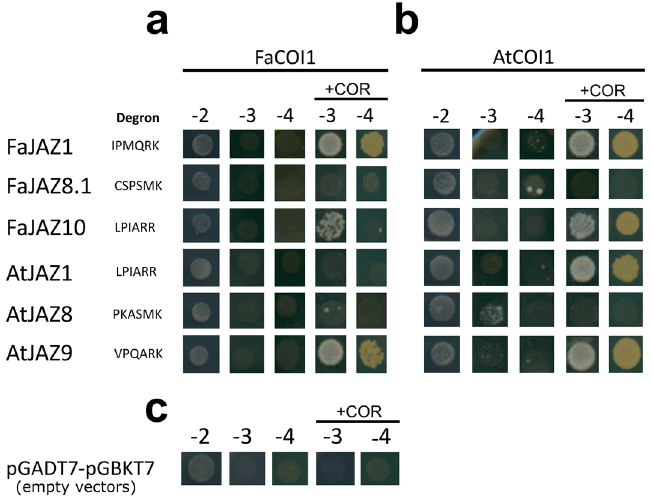
Figure 6. Yeast two-hybrid (Y2H) assays for JAZs-COI1s interactions using Fragaria × ananassa and Arabidopsis thaliana proteins. Interactions of FaCOI1 ( a ) and AtCOI1 ( b ) with JAZs repressors of Fragaria × ananassa and Arabidopsis thaliana under absence or presence of COR. Negative controls ( c ) with pGADT7-(AD) and pGBKT7-(DBD) empty vectors under the absence/presence of COR. − 2, SD-Leu-Trp;